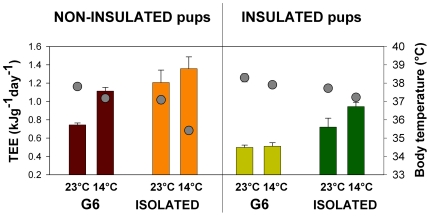
Total energy expenditure (TEE, kJg−1day−1; bars) and body temperature (°C; circles) for each pup category (G6 huddling and G1 isolated pups, insulated and non-insulated, exposed at 23°C and 14°C).